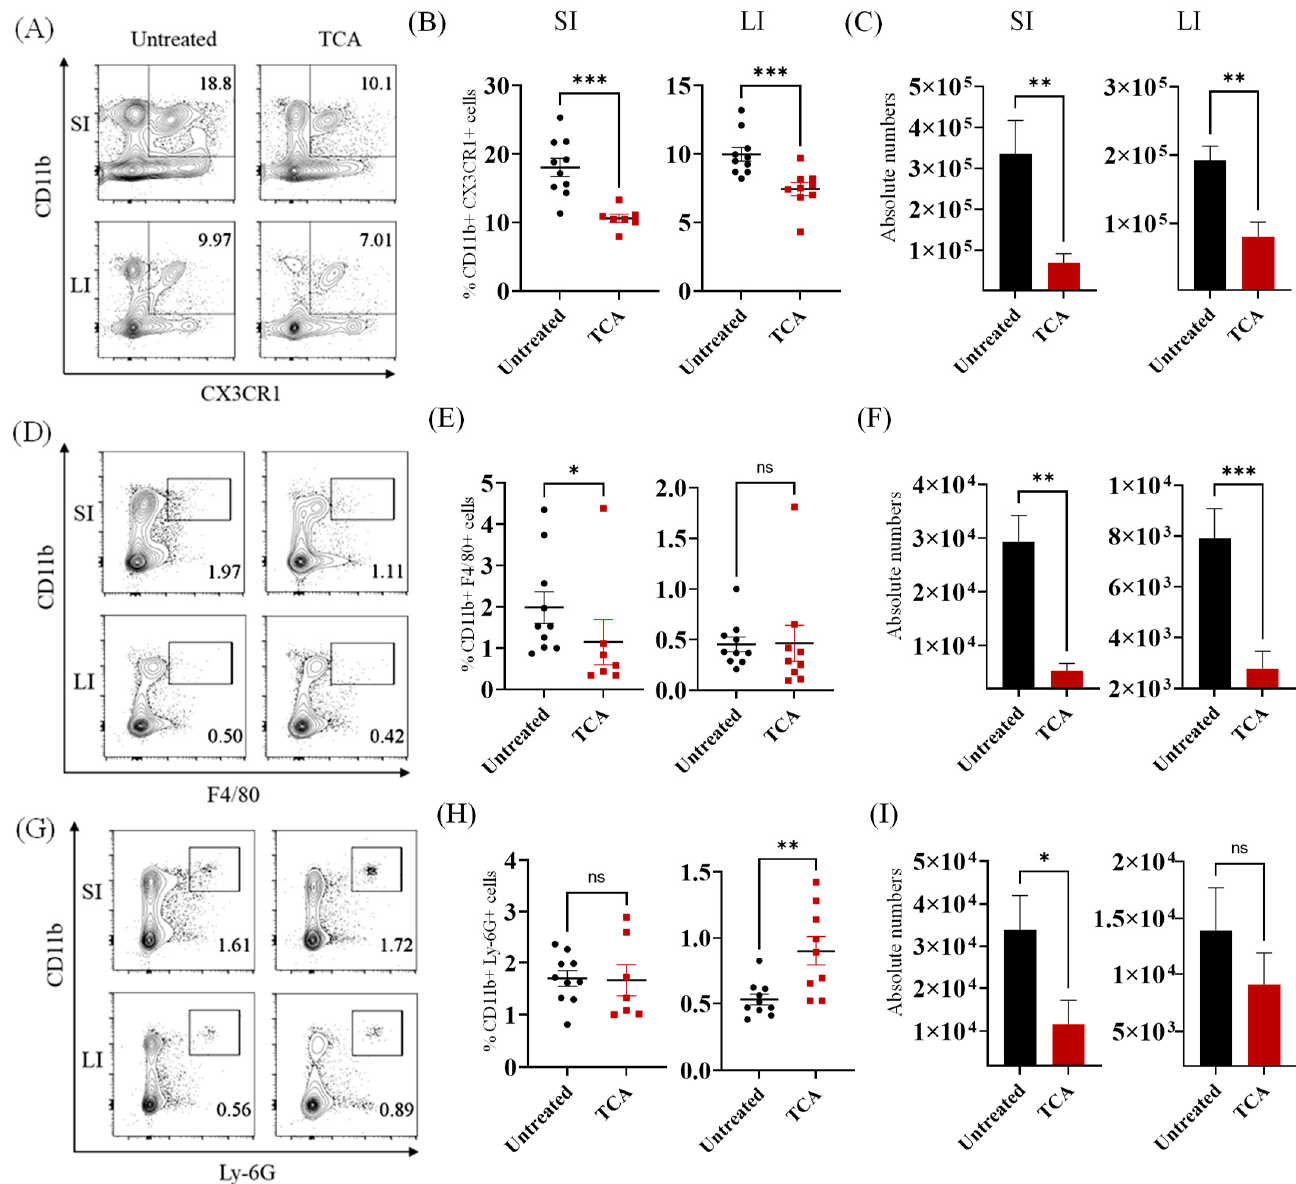
Figure 1. TCA significantly decreased the mononuclear phagocytes in the intestine. Groups of mice infected with ~1 × 10 7 CFU of CA SC5314 via oral gavage. Control group received sterile drinking water and TCA group received drinking water containing 1% TCA. Eight days post-infection and treatment, mice were euthanized to isolated mononuclear cells from small and large intestine. Cells were labeled with indicated markers to determine macrophages and neutrophils population in the intestine. ( A ) Representative images; ( B ) percentage and ( C ) absolute number of CD11b+ CX3CR1+ phagocytes from small intestine (SI) and large intestine (LI) of untreated and TCA-treated mice were shown. ( D ) Representative images; ( E ) percentage and ( F ) absolute number of CD11b+ F4/80+ macrophages from SI and LI of untreated and TCA-treated mice were shown. ( G ) Representative images; ( H ) percentage and ( I ) absolute number of CD11b+ Ly6G+ neutrophils from SI and LI of untreated and TCA-treated mice were shown. Data shown are combined from 2 independent experiments for a total of 7 to 10 mice per group. Data represent mean ± SEM. The statistical significance of differences between groups was determined by the Mann-Whitney U test with * p ≤ 0.05, ** p ≤ 0.01, and *** p ≤ 0.001.